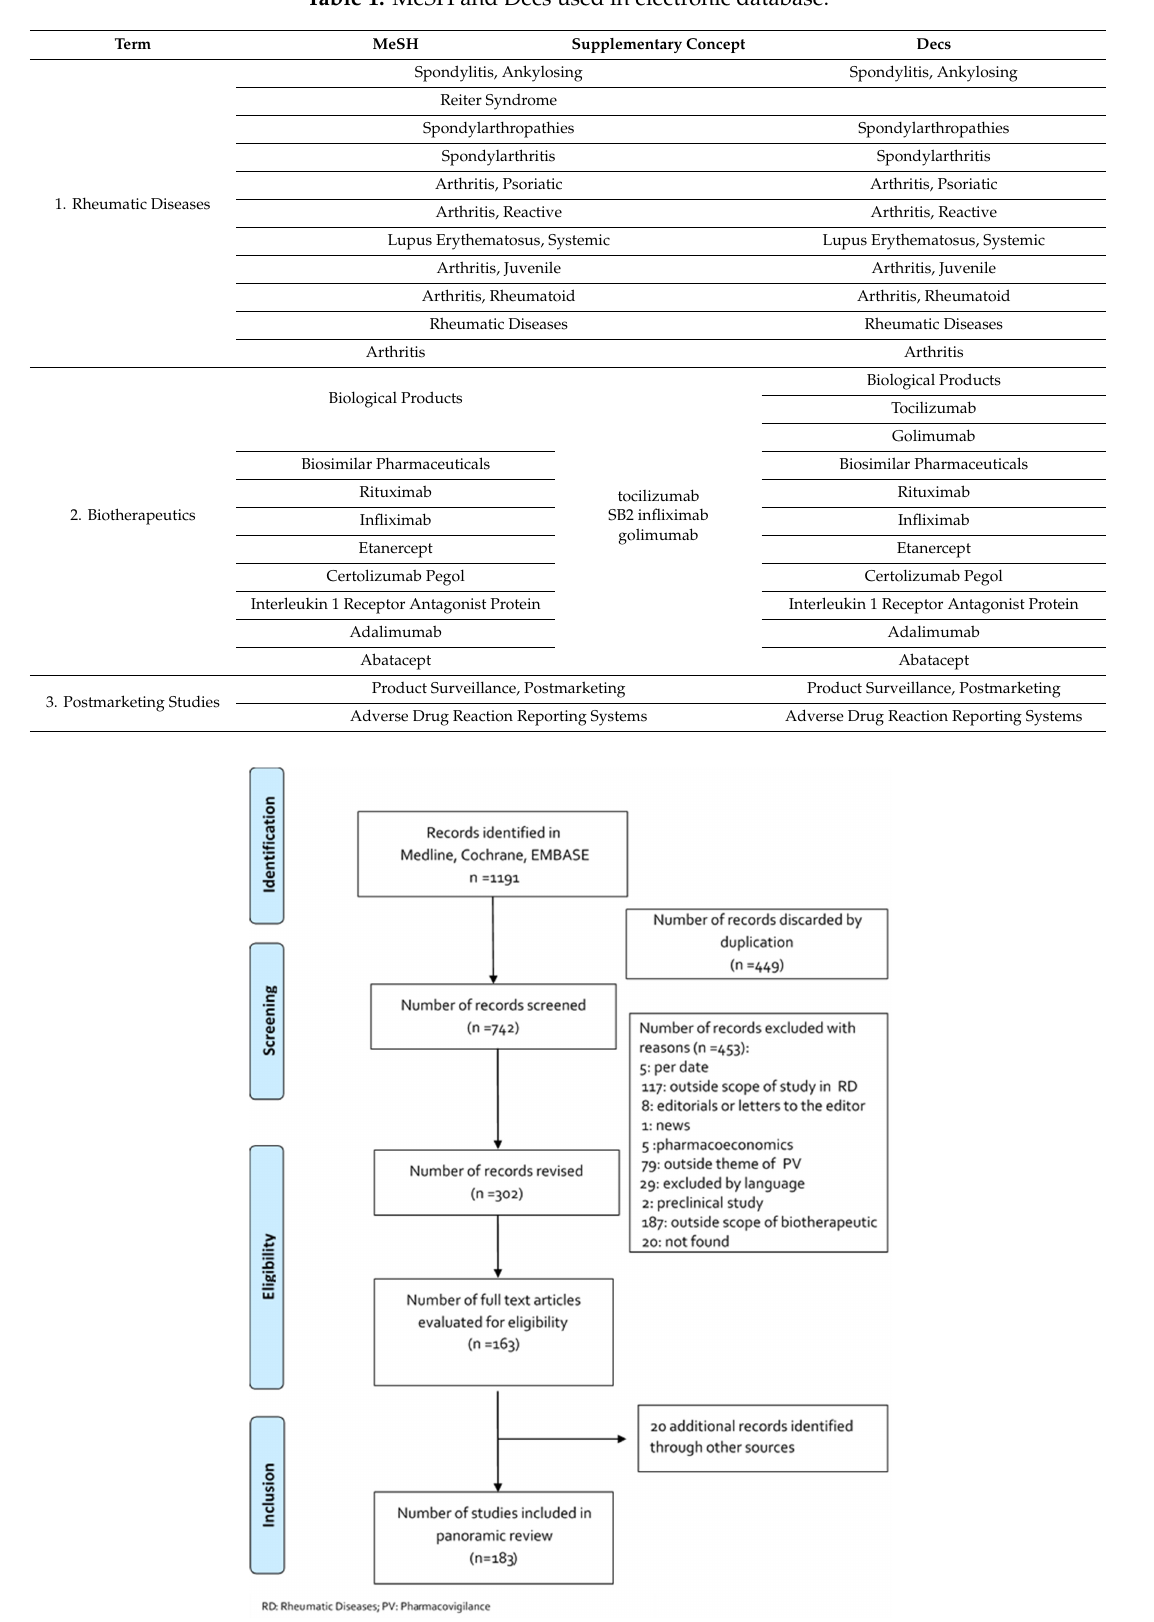
Figure 1. Flowchart depicting the selection process for the studies included in the paper. 3. Challenges Associated with the Pharmacovigilance of Biopharmaceuticals for Rheumatic Diseases 3.1. Importance of Pharmacovigilance for the Minimisation of Adverse Drug Reactions According to the WHO, PV is defined as the ‘detection, evaluation, understanding, and prevention of adverse drug events or any other related problem’ [8]. This definition agrees with what is stipulated by the EMA, which defines PV as the ‘process and science of monitoring the safety of drugs and taking measures to reduce the risks and increase the benefits of drugs’ [9]. The WHO definition includes the term drug-related problem (DRP), which is defined by the second Granada consensus as negative clinical results, derived from pharmacotherapy and produced by various causes, leading to the non-achievement of the therapeutic objective or to the appearance of unwanted effects [10]. The best-known case of a DRP was related to the thalidomide tragedy in 1961. In this year, the PV system was created, and sought to offer an organised method where risks are identified and the